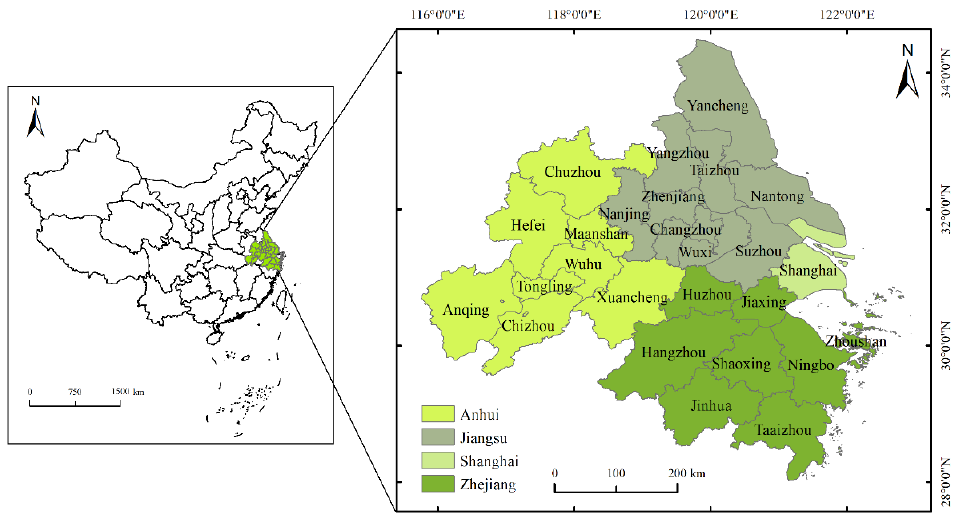
Figure 1. Location map of study area.